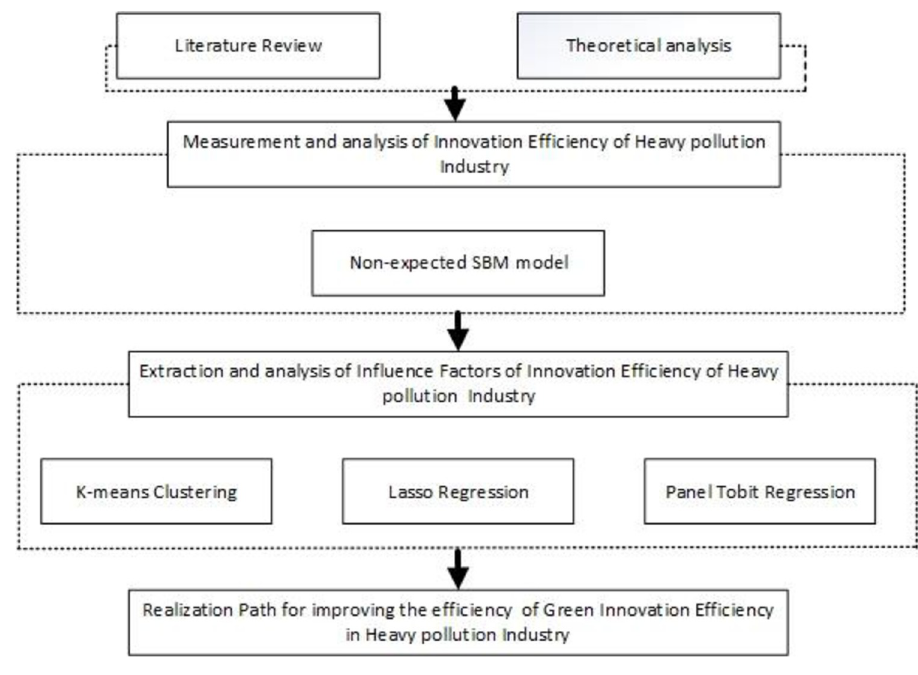
Fig 1. System framework of this